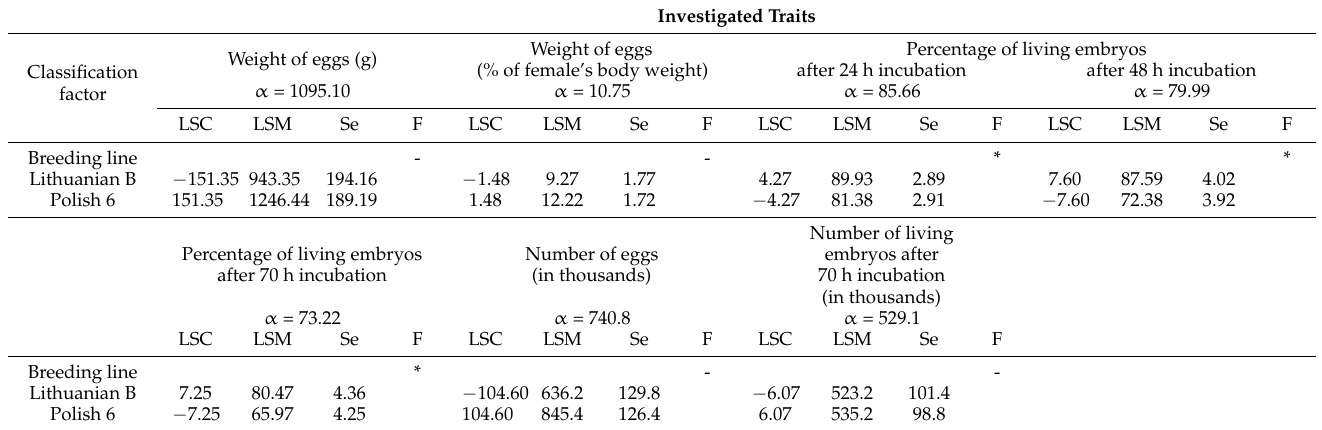
Table 1. Constants (LSC) and least-squares means (LSM) estimated for the traits determined propa- gation results of breeding lines B and 6 and results of